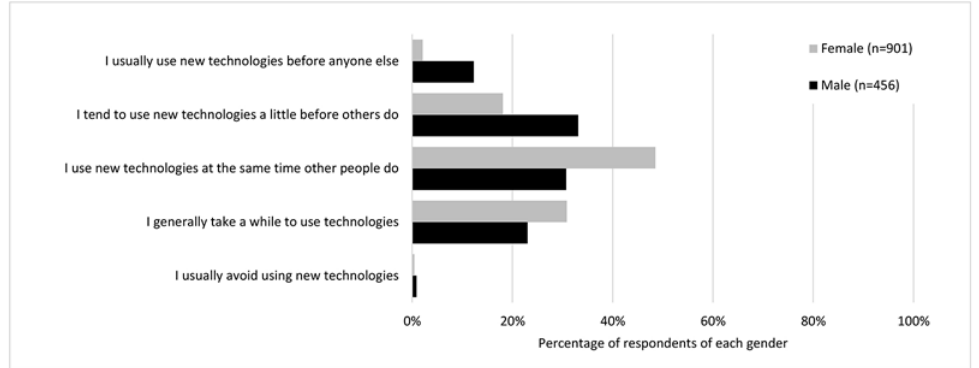
Figure 4 Technology adoption by gender